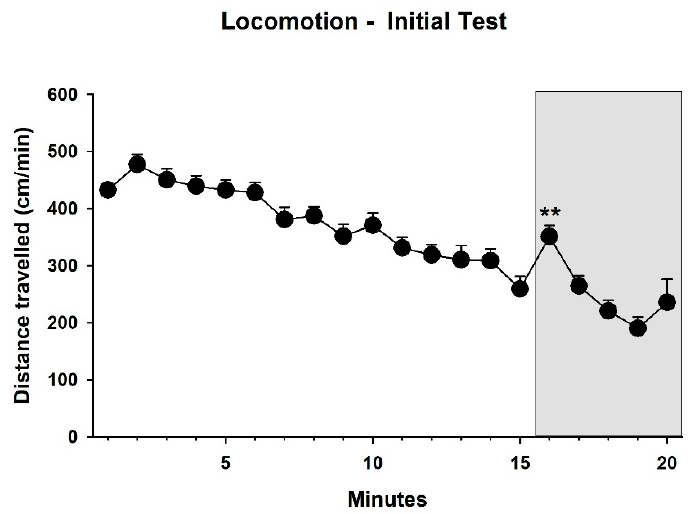
Figure 5. Locomotor activity in cm/min in the initial test during the 15 min before and the 5 min (indicated by grey background) during 50-kHz playback. During the 1st min of playback, locomotor activity increased as compared to the prior minute (** p = 0.005). Data are presented as means + SEM.